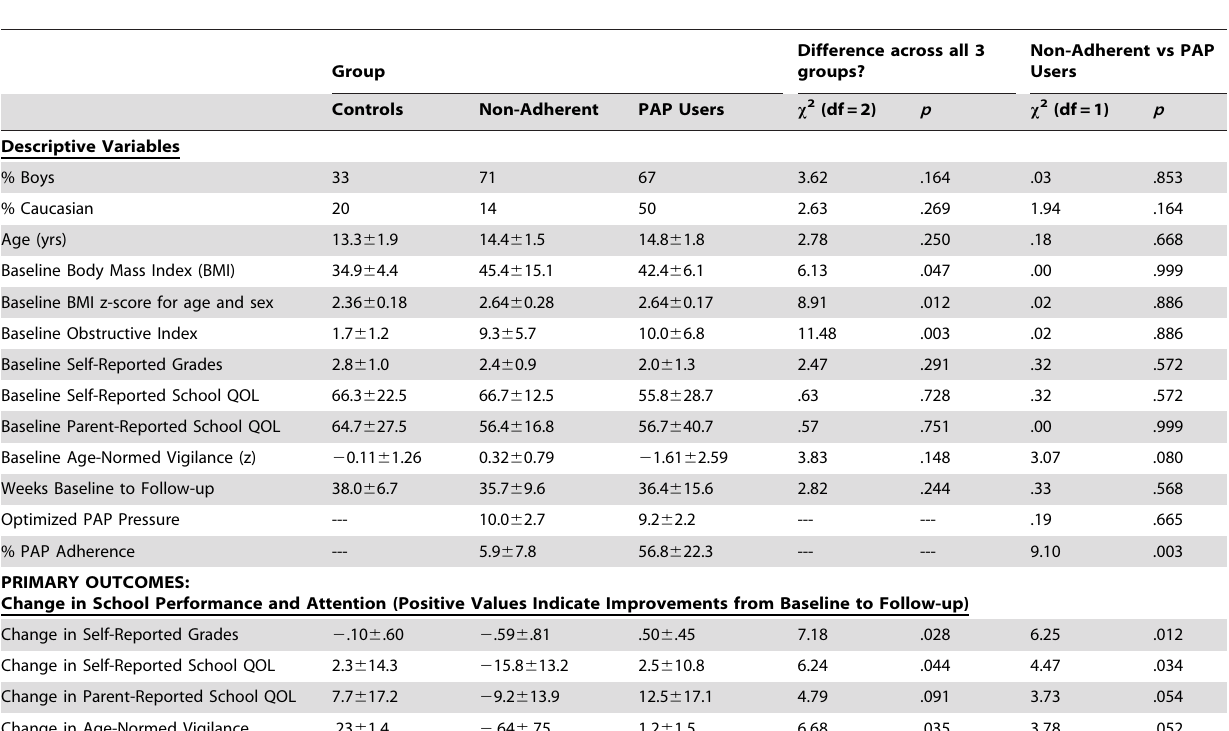
Table 1. Cross-Group Comparisons on Descriptive Variables and Change Over Time in School Performance and